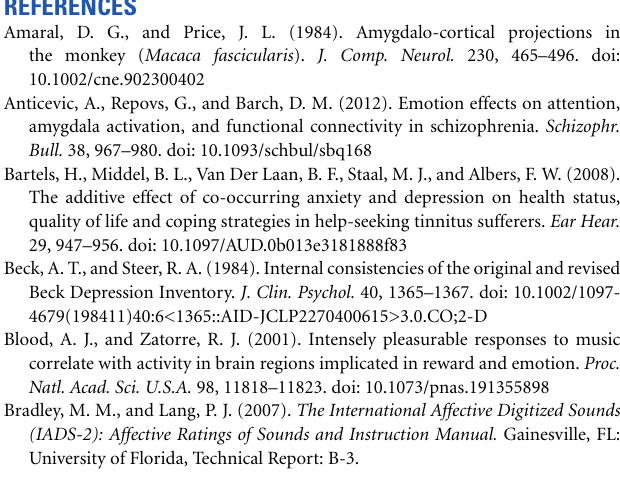
Supplementary Table 1 | Sounds included in the study. Separated by column are 30 pleasant, 30 unpleasant, and 30 neutral sounds chosen from the IADS database to be included in the